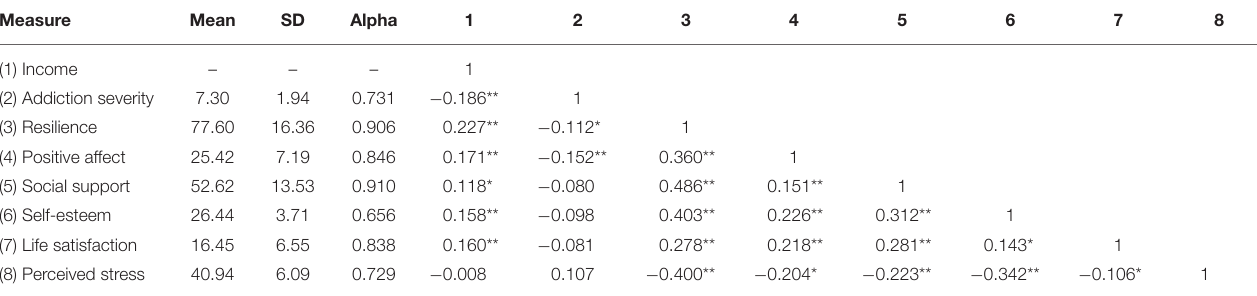
TABLE 2 | Means, standard deviations (SD), Alpha, reliabilities, and intercorrelations among study variables after controlling gender and age. Measure Mean SD